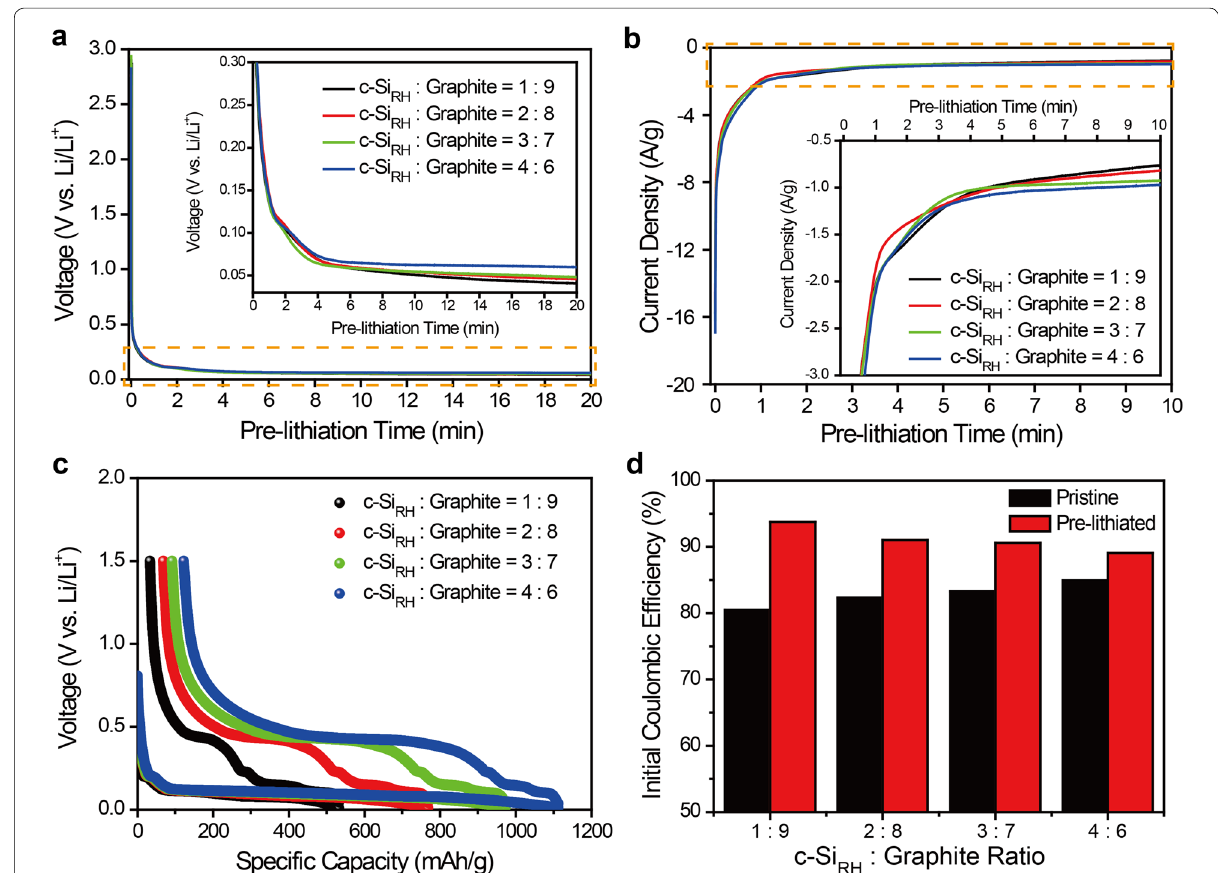
Fig. 3 Characterization of pre-lithiation of c-Si RH and graphite composite with different c-Si RH and graphite mass ratios. a Voltage profiles during the pre-lithiation when 100Ω is integrated. b External short circuit current changes during pre-lithiation. c The first cycle voltage profiles after 6 min of pre-lithiation. d Comparison of the initial Coulombic efficiencies before and after